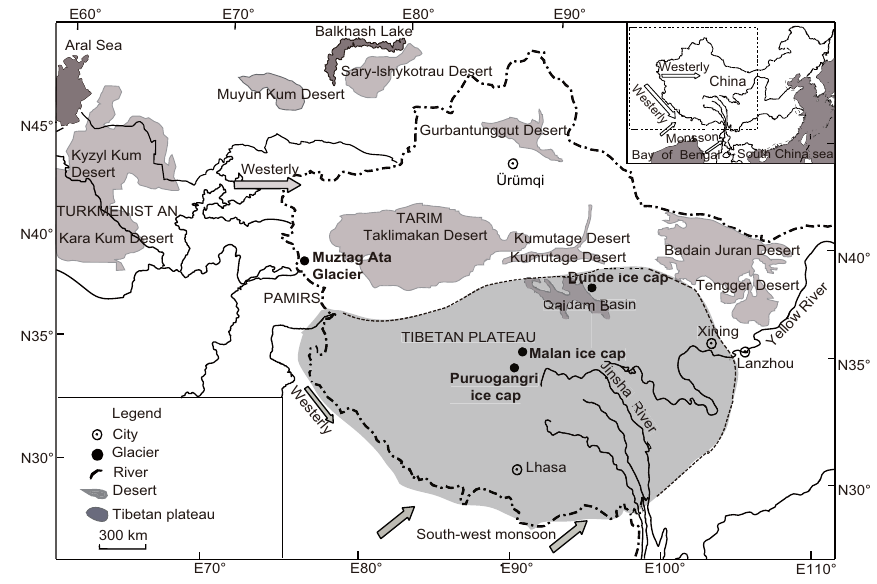
Fig. 1. Map showing the locations of four geographically isolated glaciers Muztag Ata, Puruogangri, Malan and Dunde (Map was adapted from Xiang et al.,